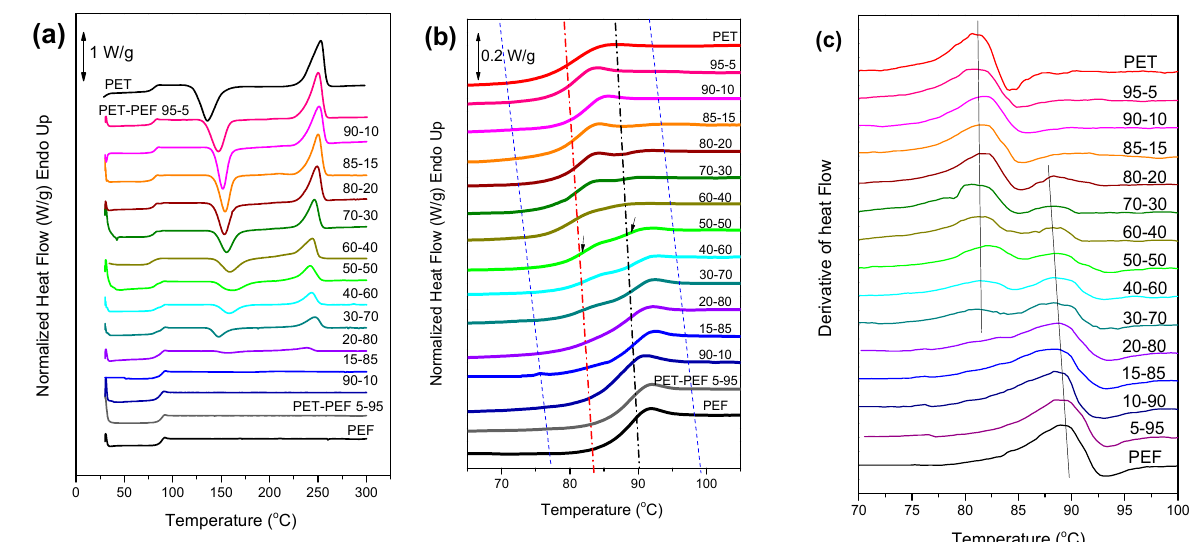
Figure 4. Power compensation DSC thermograms of melt quenched blends at 20 ◦ C/min ( a ) full temperature scale and ( b ) details of the glass transition temperature range; the black dotted line corresponds to the T g of PEF and the red dotted line corresponds to the T g of PET. ( c ) First derivative of the heat flow plotted as a function of temperature for several PET/PEF compositions. Red and blue arrows indicate glass temperatures of PEF and PET segments, respectively.